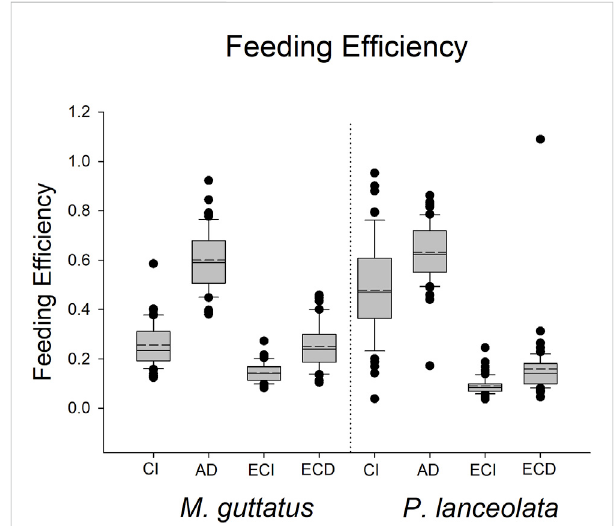
FIGURE 7 Boxplots representing the feeding ef fi ciency data for each host plant. CI = consumption index, AD = approximate digestibility, ECI = ef fi ciency of conversion of ingested food, ECD = ef fi ciency of conversion of digested